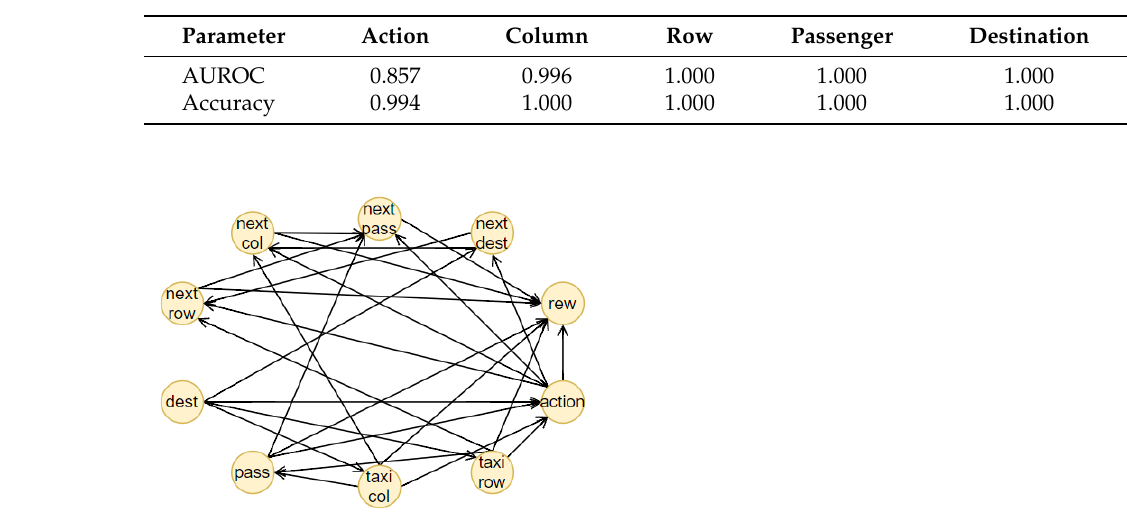
Table 1. AUROC and accuracy for the prediction of each future feature in the Taxi environment.